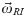
Main parameters of the model.(A) We take the theoretical optic flow vector (ω→RI) to be the opposite of the 3-D speed vector (V→RI) experienced by the hoverfly. We calculated a horizontal (ωxRfly) and a vertical (ωzRfly) component of this theoretical optic flow vector in the hoverfly’s reference frame (Rfly) depending on the estimated pitch orientation. (B) The force produced by the hoverflies’ flapping wings (F→) is assumed to be orthogonally oriented with respect to the body pitch orientation [11]. Moving forward is then achieved by pitching down from the head and moving backward, or braking, by pitching up from the head. Lift force (L→) corresponds to the vertical component of F→ in the inertial reference frame and thrust force (T→) to the horizontal component. As depicted in [35], we assumed a pure active control of the pitch torque which is seen to occur during a fraction of the wingstroke, about half of a wing beat period (i.e., about 2ms for an hoverfly, see [3]).